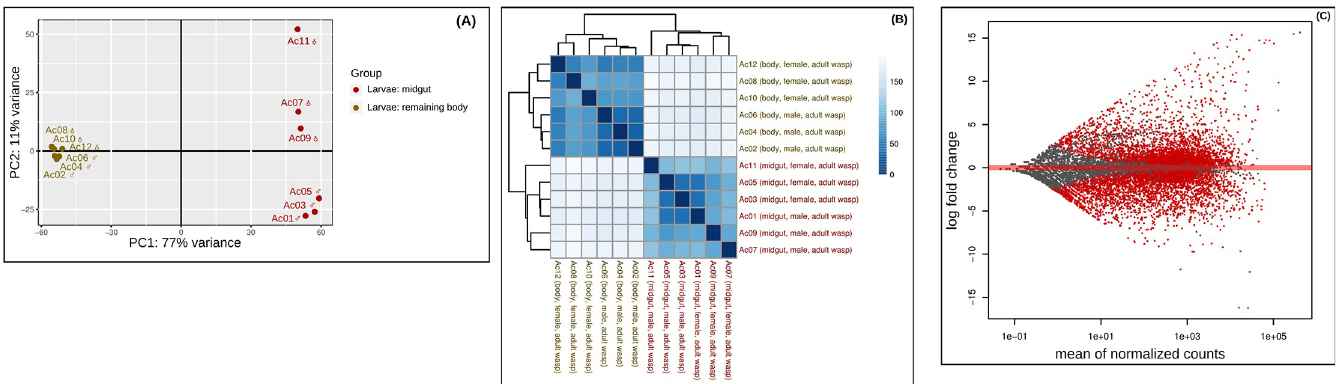
Fig 2. Principal component analysis, heatmap and MA plot. ( A ) Principal component analysis (PCA) of all genes with normalized counts. The plot shows the distribution of the 12 adult wasps transcriptome samples analyzed in the DESeq2 analysis A. The first dimension separates samples by body part i . e ., midgut vs. remaining body, and the second separates samples by sex i . e ., female and male adult wasps. ( B ) Heatmap of the sample-to-sample distances based on the normalized counts. Samples are grouped by body part (midgut vs . remaining body) as shown in the PCA plot. Color represents distance between the samples. Dark blue means shorter distance. ( C ) MA plot of the log2 fold change of all genes. Genes that passed the significance threshold (adjusted p -value < 0.1) are colored in red.